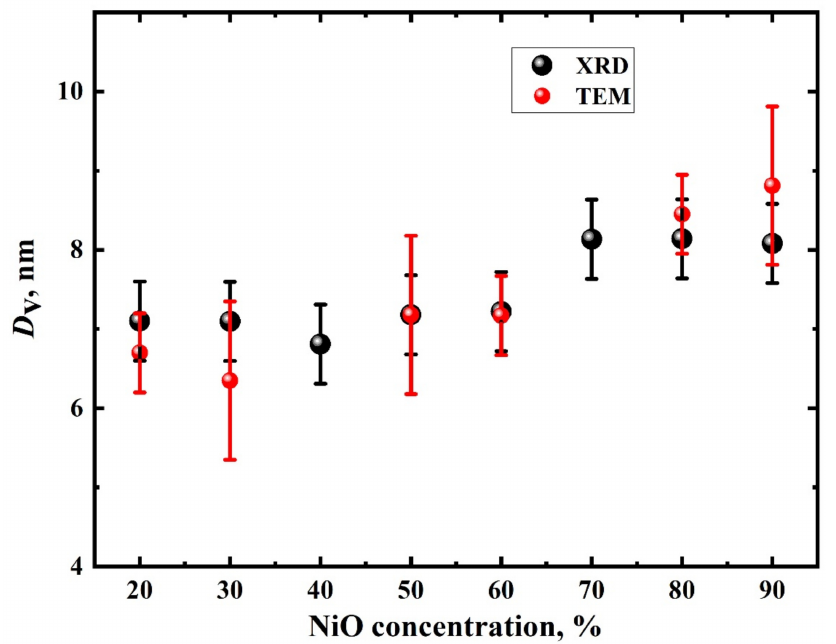
Figure 2. Nanoparticle average sizes evaluated from XRD (black circles) and TEM (red circles)